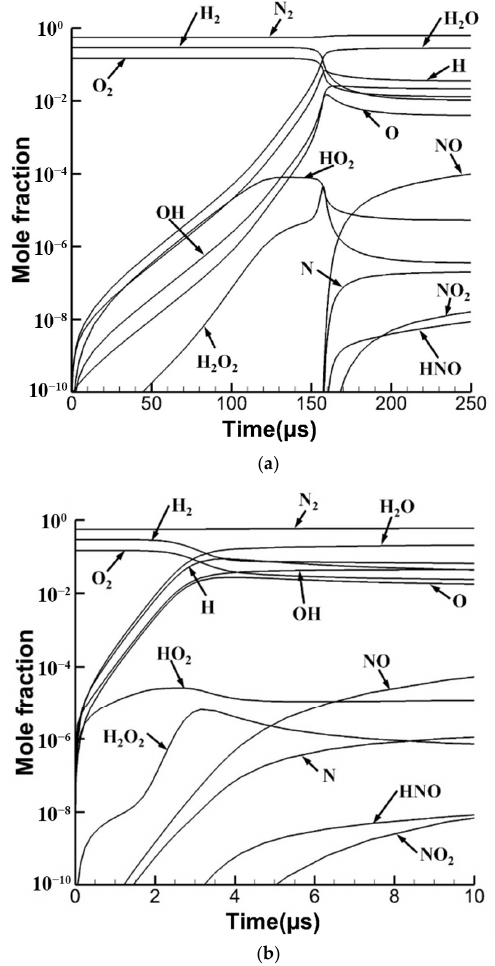
Figure 4. Mole fraction of products during unsteady-state combustion. ( a ) 1000 K. ( b ) 2000 K. The analysis of the chemical reaction rates of the steady-state combustion of the H 2 – air mixture is analyzed to distinguish the dominant reactions for the main products N 2 , N, and NO, where the pressure is 1 atm and temperature is 2000 K. The results show that the dominant nitrogenous reactions are N + O 2 = NO + O, N + NO = N 2 + O, and N + OH = NO + H, namely thermal NO reactions, which are consistent with the reference [37]. The productivities of these species are shown in Figure 5. The N is not mainly produced by the decomposition reaction N + N + M = N 2 + M but the exchange reaction N + OH = NO + H, which is included in the hybrid kinetic scheme.